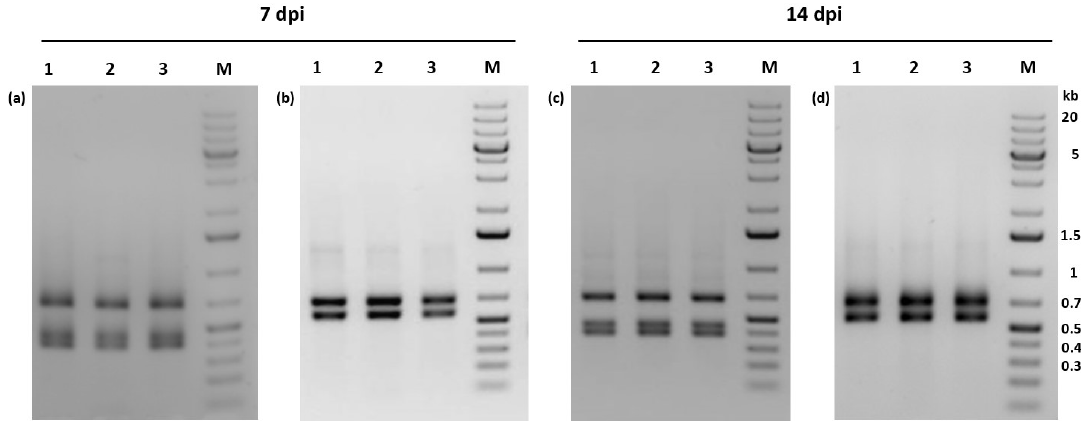
Figure 5. Agarose gel electrophoresis (1%) of AluI digests of egt-specific PCR fragments